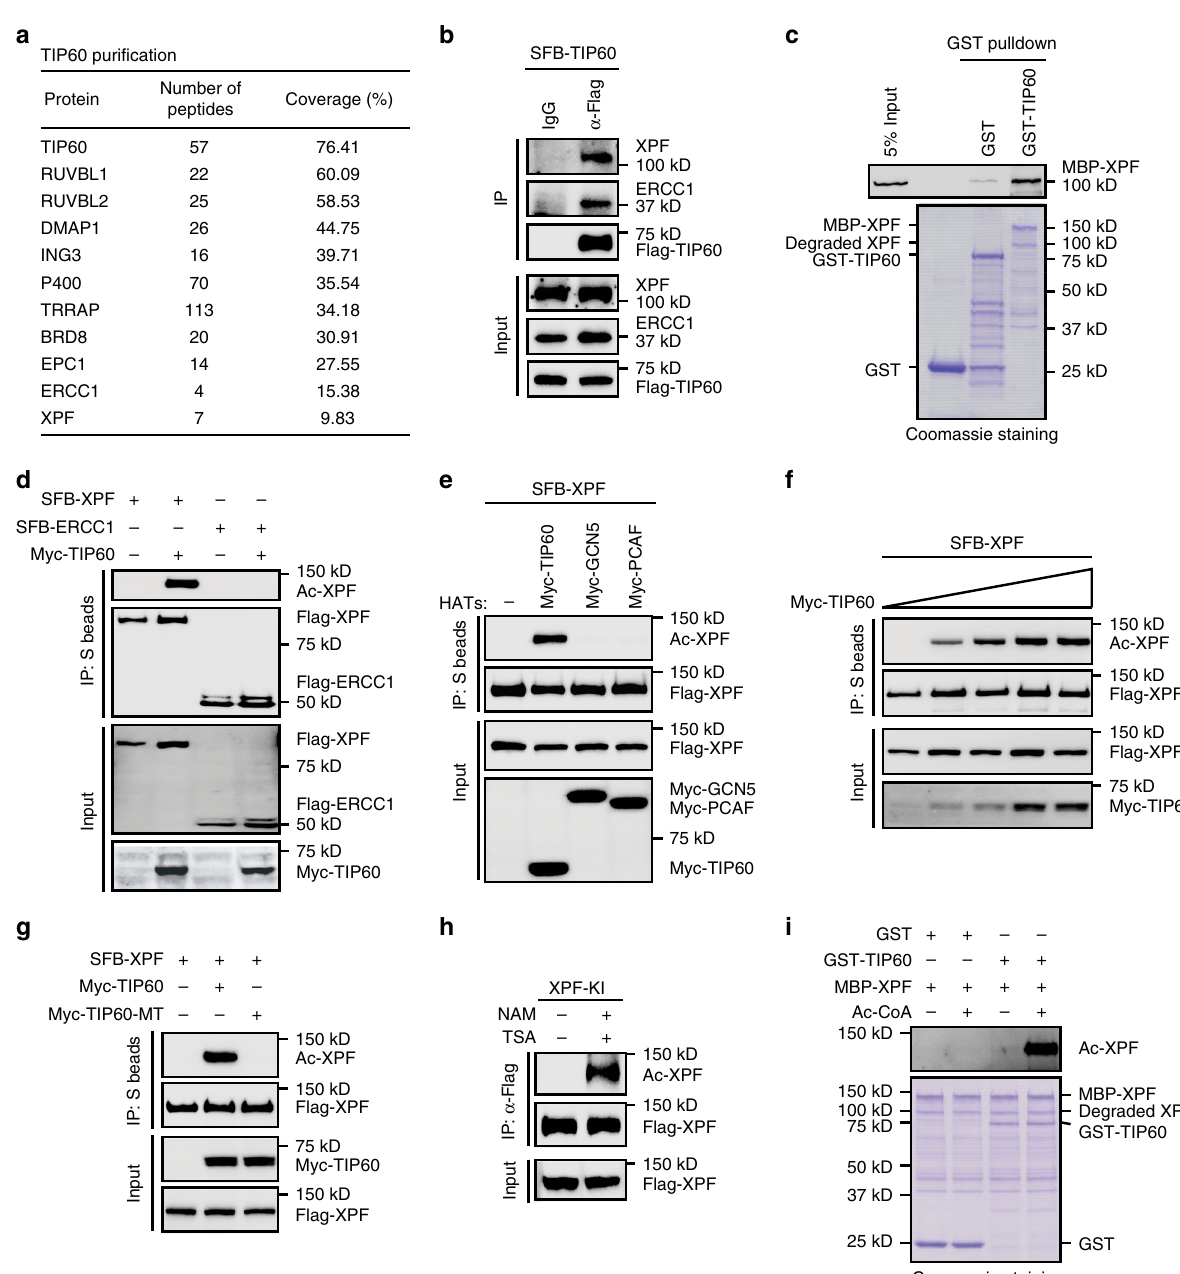
Fig. 2 TIP60 interacts with and acetylates XPF. a Tandem af fi nity puri fi cation of TIP60 protein complexes. Proteins identi fi ed by Mass spectrometry